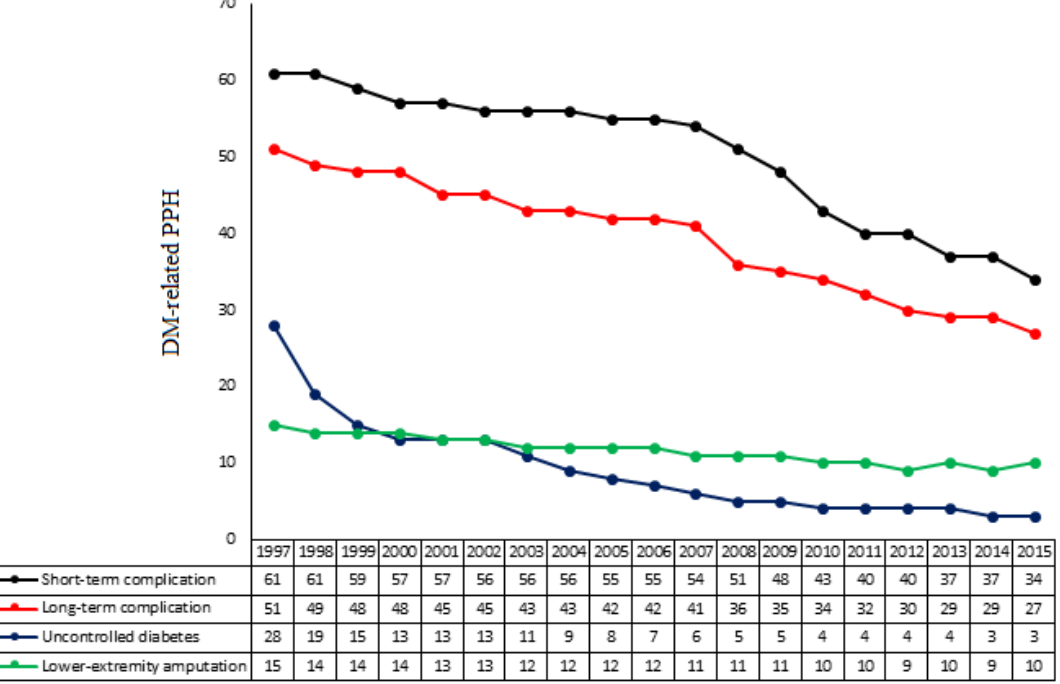
Figure 2. Adjusted number of diabetes-related potentially preventable hospitalizations according to preventable condition from 1997 to 2015. Data were calculated per 1,000 hospitalized patients with diabetes mellitus per year. DM: diabetes mellitus; PPH: potentially preventable